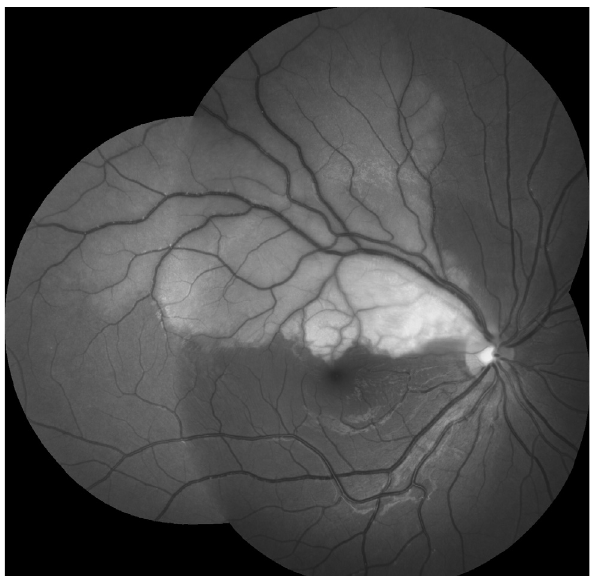
Fig. 2. FAG. Normal retinal vasculature on the right eye due retinal arterial stage.